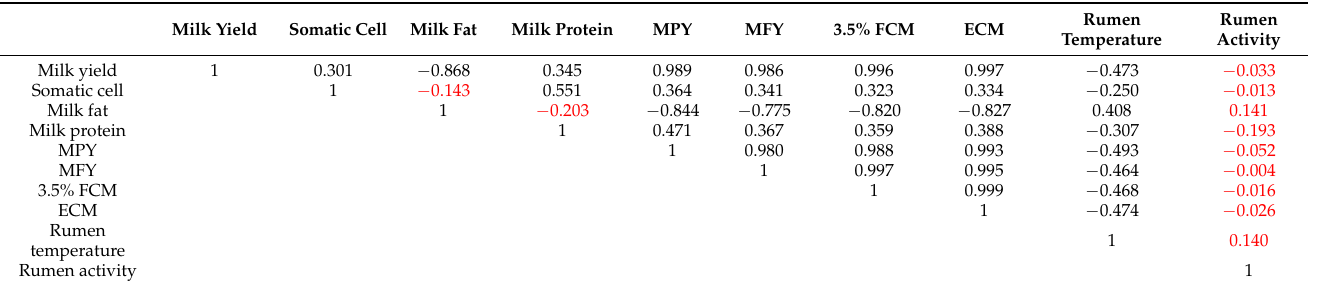
Table 7. Pearson’s correlation coefficient of considered traits for daily milking and rumen characteris- tics at Farm A.